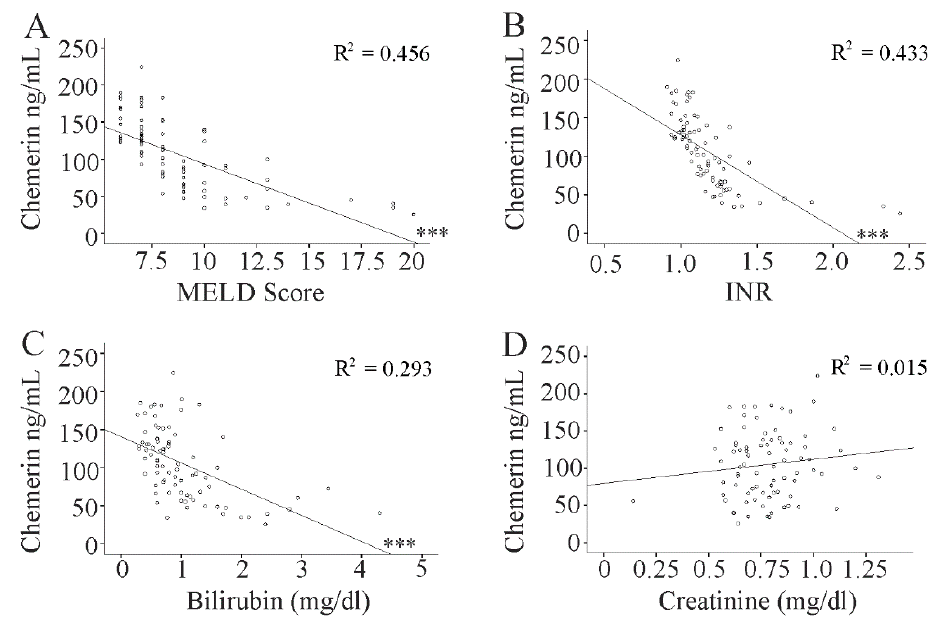
Figure 2. Correlation of serum chemerin with markers of liver injury. Correlation of chemerin with ( A ) the MELD score; ( B ) INR; ( C ) bilirubin; and ( D ) creatinine. *** p < 0.001.